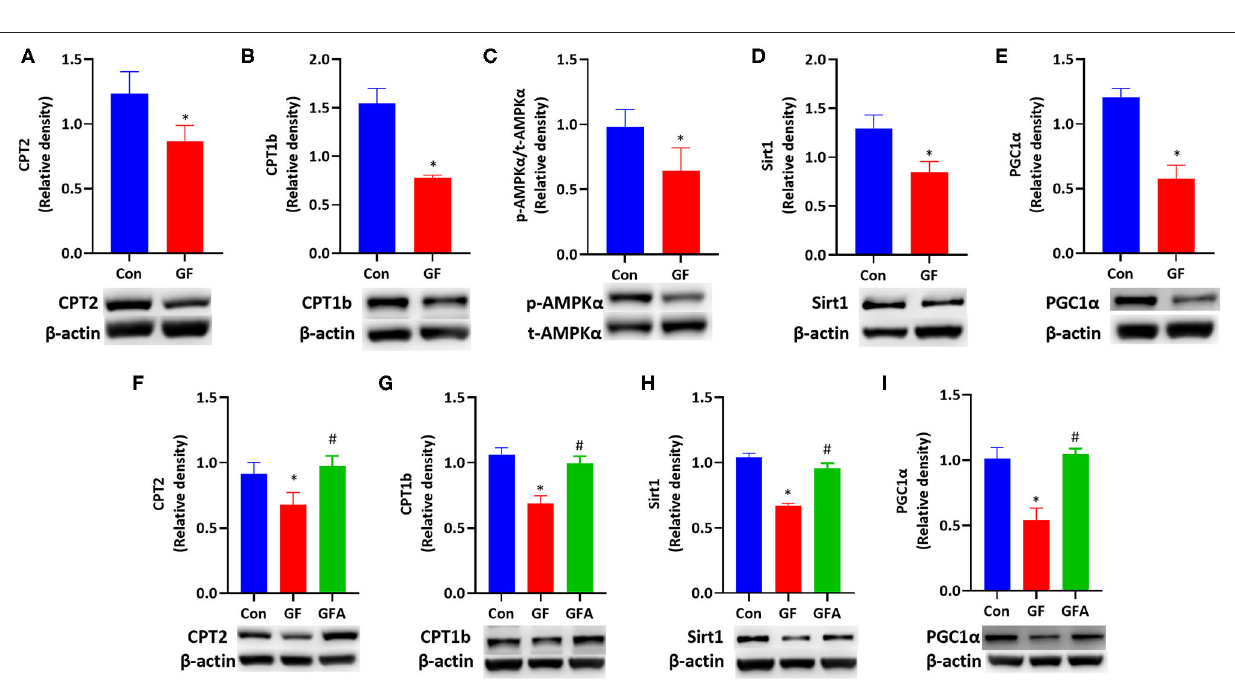
enzyme activity of CPT1 in the liver (37–39). Since the fetus and sucking infant have a very limited ability to synthesize carnitine, it